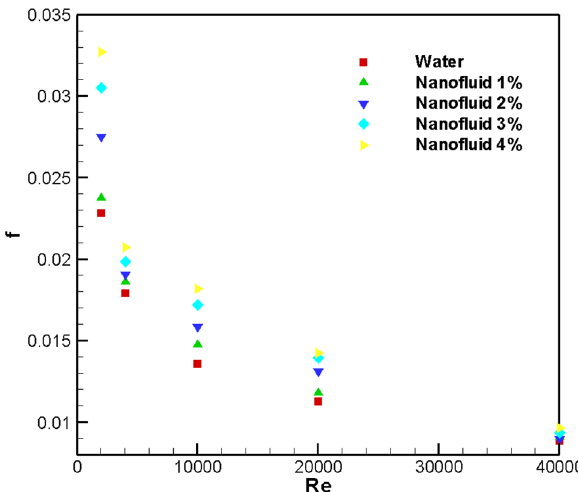
Fig. 8 Friction factor versus Reynolds number by different volume fractions of cooling fluid